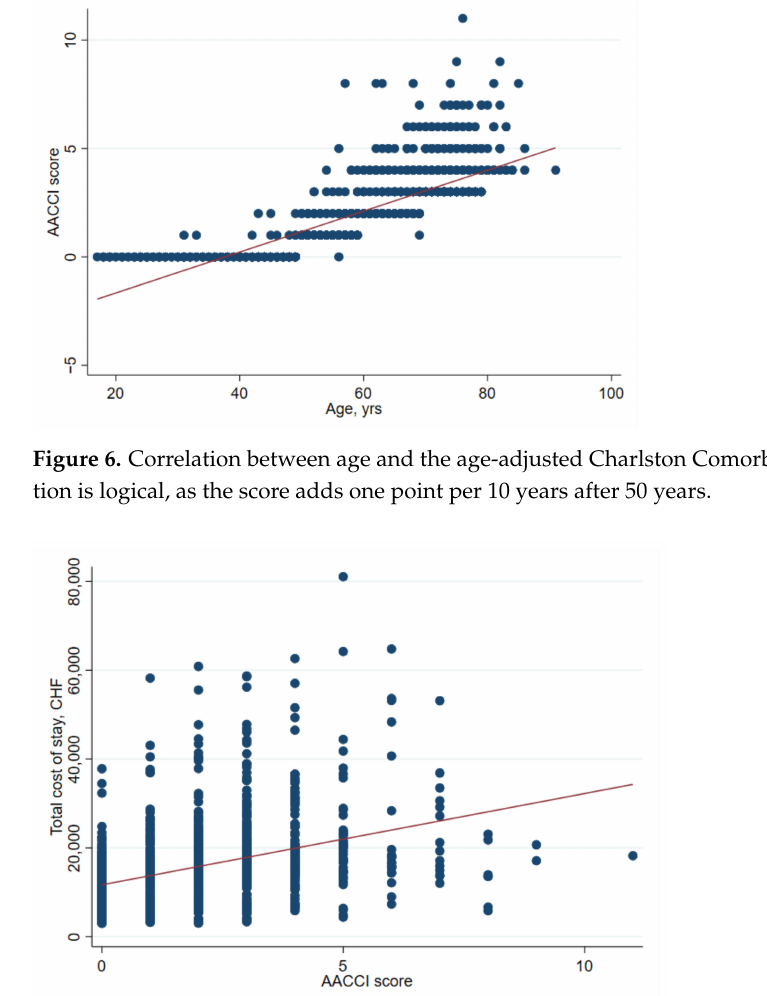
Figure 7. Correlation between total cost of stay and AACCI-cost of stay increases with more comor-